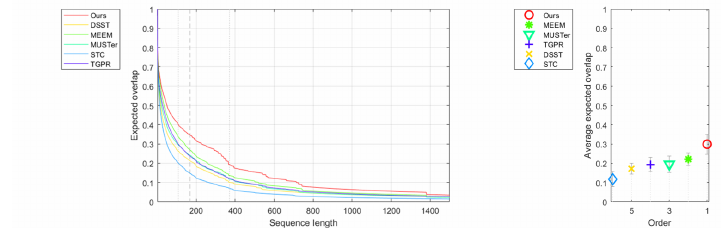
Figure 8. Expected average overlap curves and scores for the experiment baseline on the VOT-2015